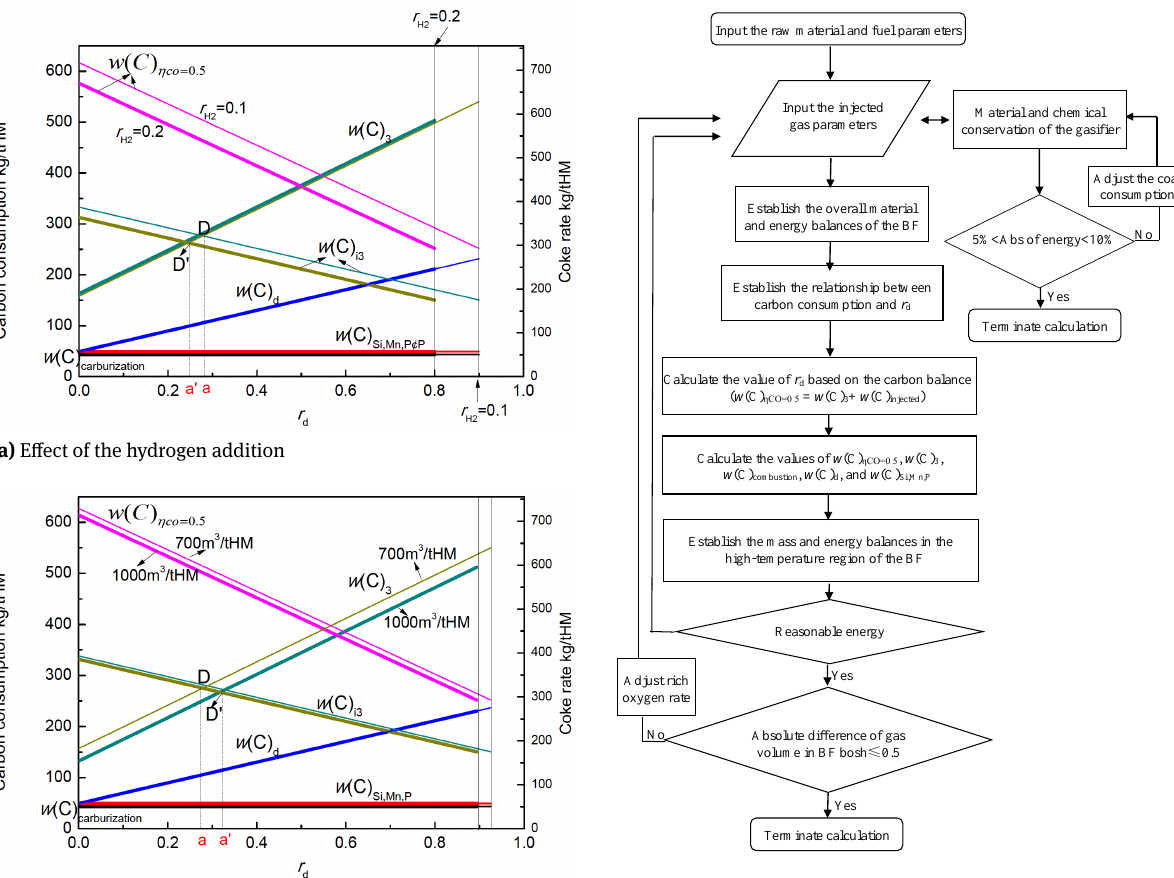
Figure 5: Roadmap of the calculation model for the gas-injection BF